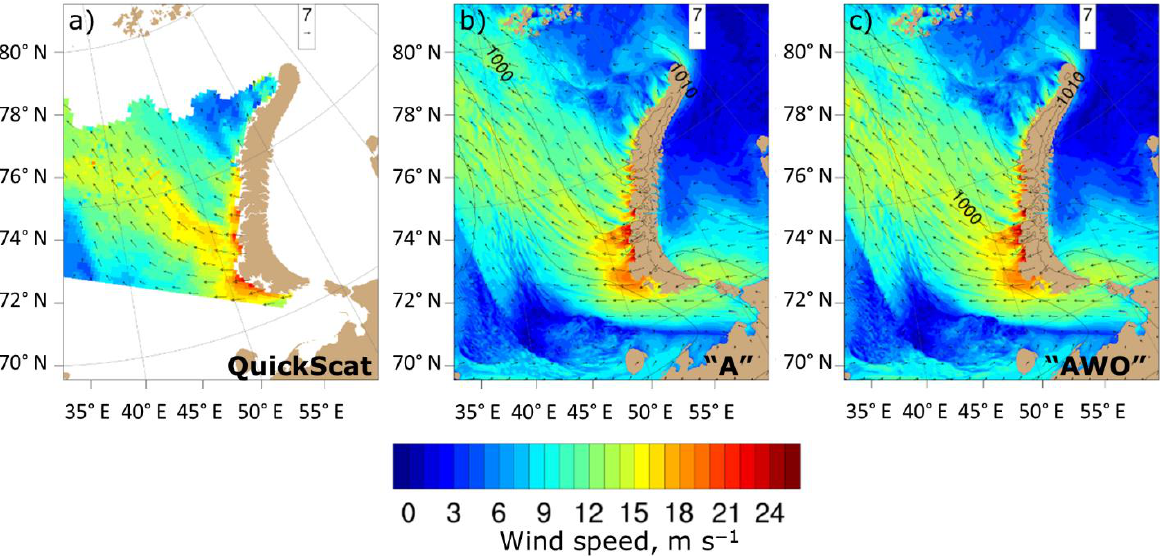
Figure 3. Wind speed and direction from scatterometer data ( a ) and experiments “A” ( b ) and “AWO” ( c ) at 22 UTC on 10 December 2006. Grey contours show sea-level pressure (hPa). Table 2. Statistical characteristics of model errors in wind speed (m s − 1 ) when compared with the altimeter data during the period 10–12 December